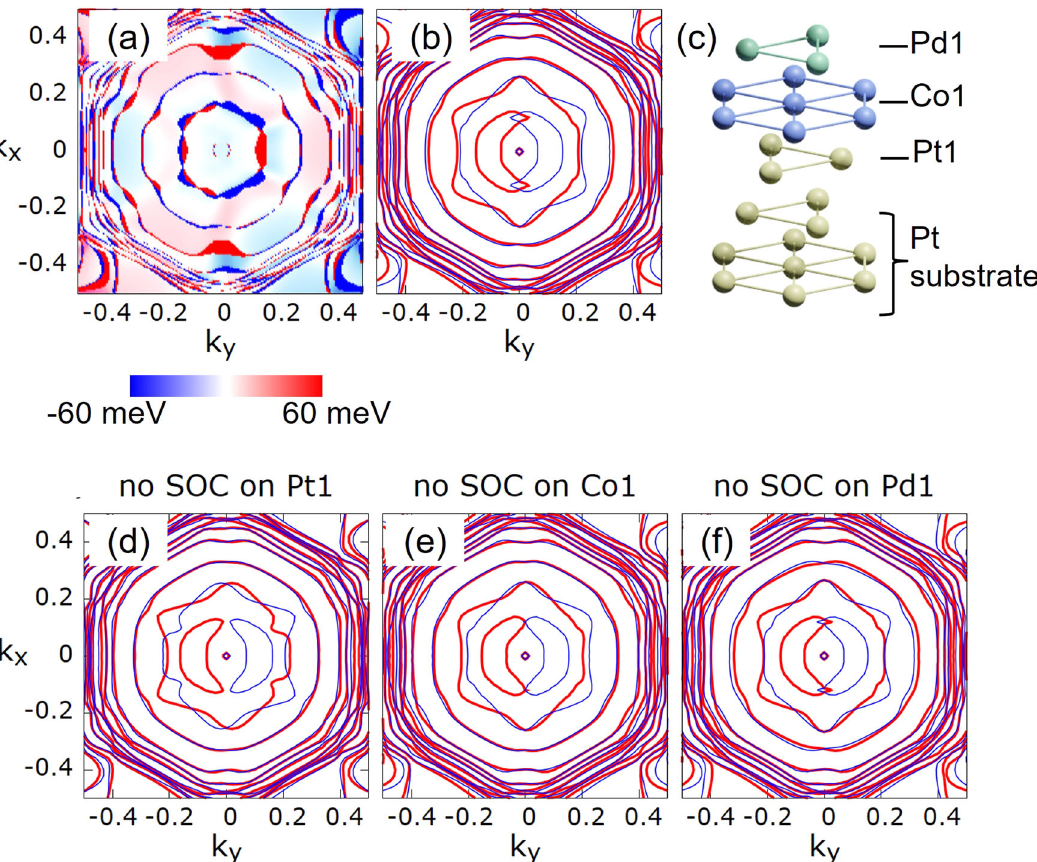
Fig. 3 k-dependent MCA energy and Fermi surface in the [Pt/Co/Pd] unit structure. a Two-dimensional ( k x , k y ) contour map of k -dependent MCA energy and b Fermi surface for different in-plane magnetization directions along + x and – x axes, plotted using respectively red and blue lines, of the [Pt/Co/Pd] 1 model system depicted in ( c ). d – f Fermi surface of the [Pt/Co/Pd] 1 model system in the absence of SOC on the Pt1, Co1, and Pd1 layer,